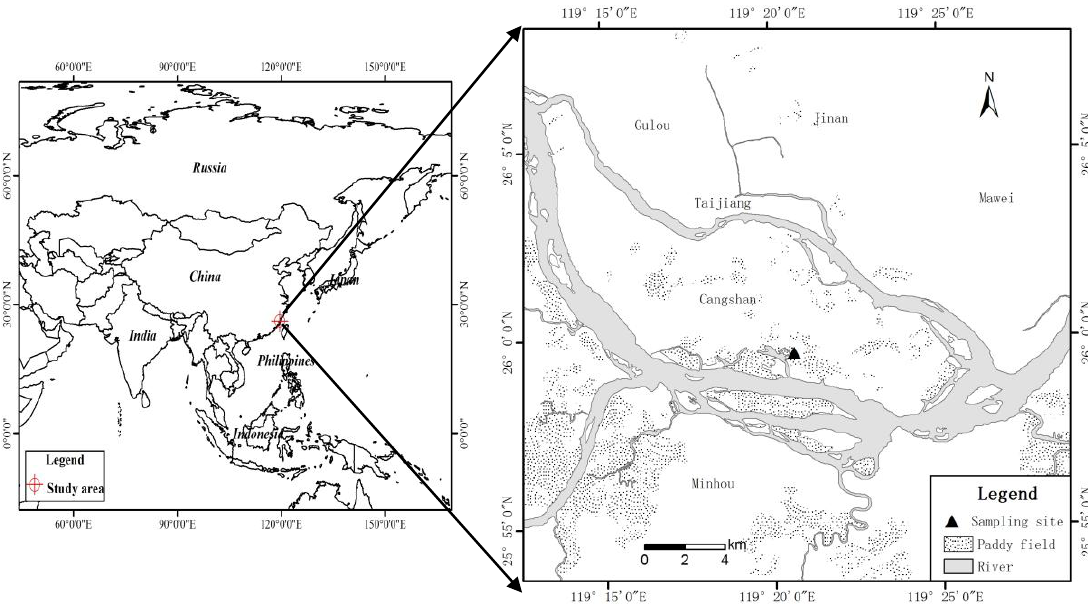
Figure 7. The location of the study area and sampling site in Fujian province, southeastern China.